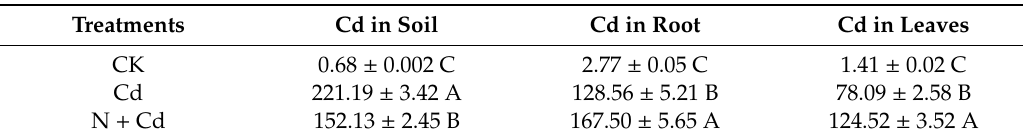
Table 3. The application of nitrogen under Cd stress may significantly increase cadmium absorption by poplar plants from soil (unit: mg · kg − 1 ).